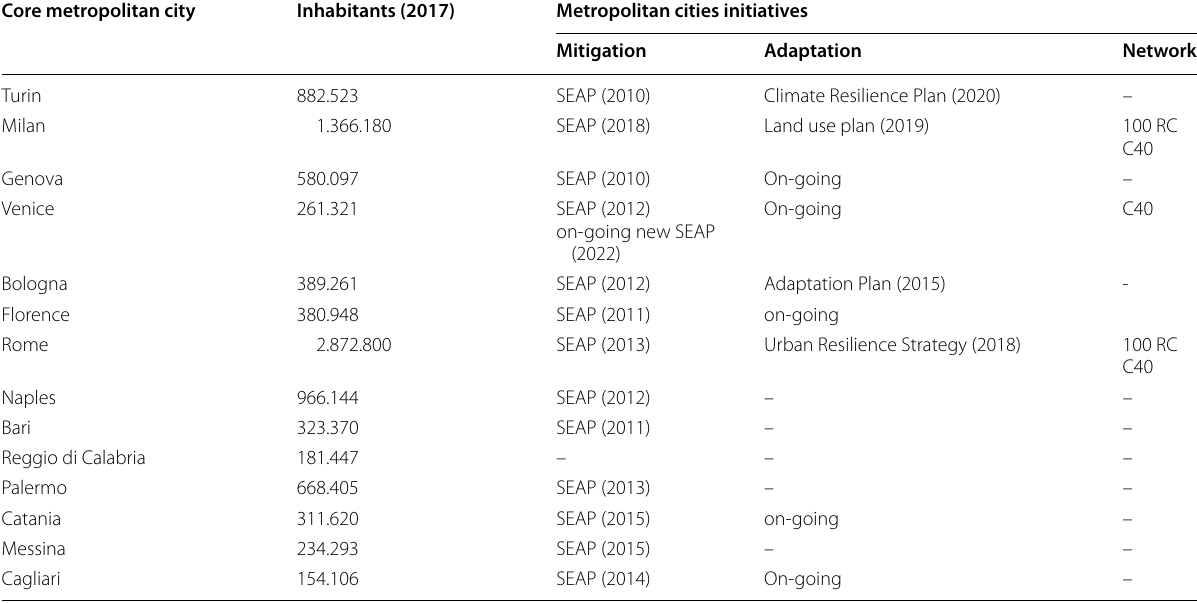
Table 2 Overview of the core metropolitan cities resilience initiatives (update 2020).